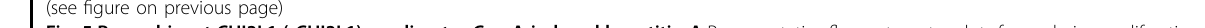
Fig. 5 Recombinant CHI3L1 (rCHI3L1) ameliorates Con A-induced hepatitis. A Representative fl ow cytometry plots for analysing proliferation of CD3 + T cells labelled with CFSE treated with rCHI3L1 in indicated conditions. PBS was used as a control. B Quanti fi cation of fl ow cytometry analysis for proliferation of CD3 + T cells labelled with CFSE in PBS (control) or rCHI3L1 (100 ng/mL) treated group ( n = 3 biological replicates). C – F Representative plots ( C – D ) and quanti fi cation ( E – F ) of fl ow cytometry analysis for CD25 and CD69 expression in CD3 + T cells treated with control (PBS) or rCHI3L1 (100ng/mL) ( n = 3 biological replicates). G – J Representative plots ( G – H ) and quanti fi cation ( I – J ) of fl ow cytometry analysis for IFN- γ and TNF- α expression in CD3 + T cells treated with control (PBS) or rCHI3L1 (100 ng/mL) ( n = 3 biological replicates). K Representative H&E staining photographs of liver tissues 24 h after Con A administration in control (PBS) and rCHI3L1 (500ng) treated groups. Scale bar = 100 μ m. L Serum ALT and AST ( M ) levels 24 h after Con A treatment in indicated groups ( n = 4 – 7 mice per group). Data in ( B ), ( E ), ( F ), ( I ), ( J ), ( L ), and ( M ) are shown as mean ± SD with indicated signi fi cance (* p < 0.05, ** p <